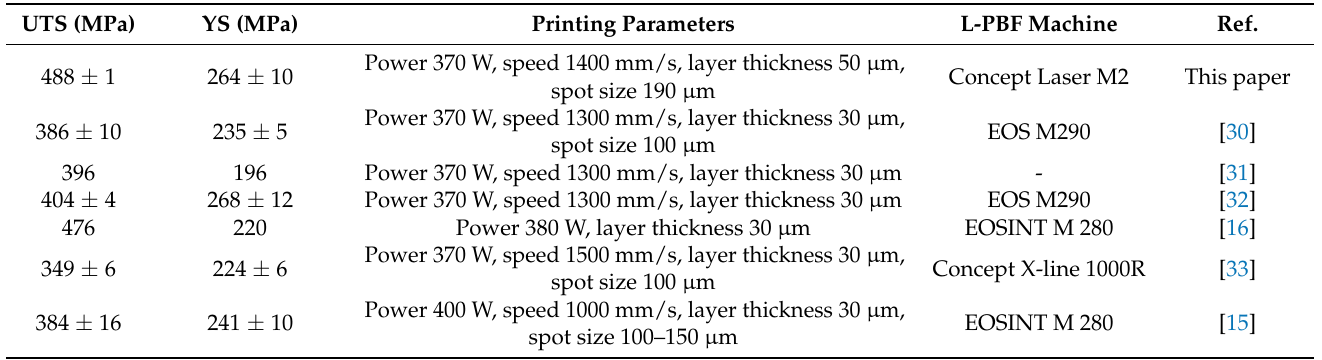
Table 5. Mechanical properties of evaluated as-built state L-PBF AlSi10Mg in comparison with other papers.